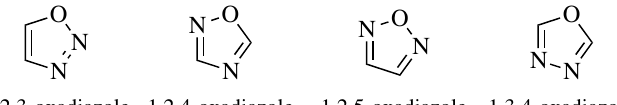
Figure 1. Chemical structures of oxadiazole